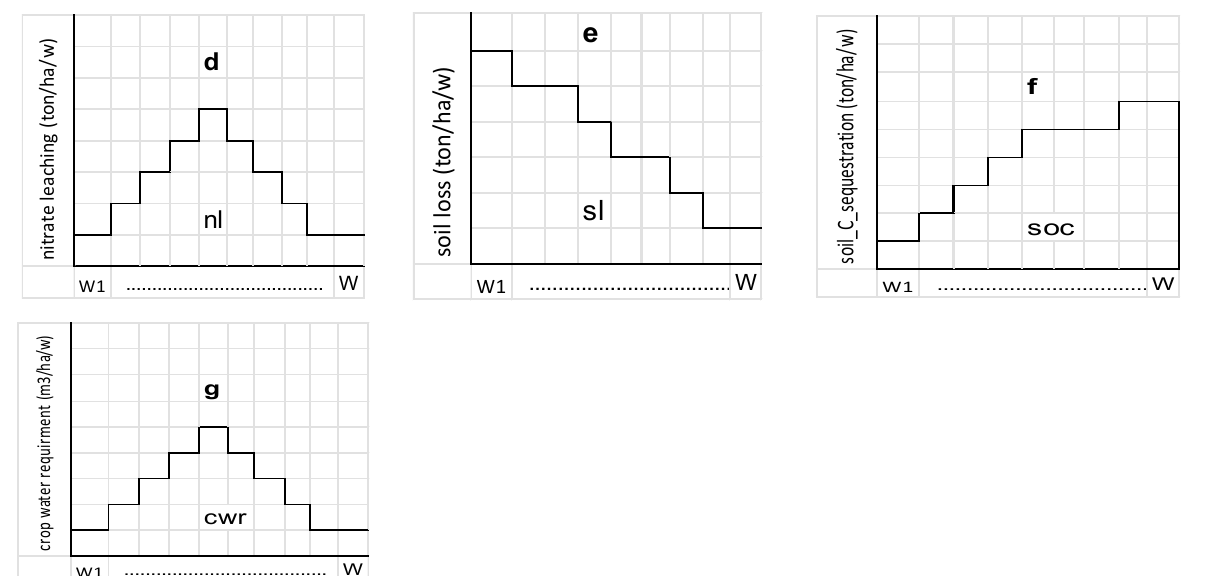
7 of 38 Figure 7. Input data used for the land attribute data sets for alternative crop succession type P1 per unit land per week for one year . (L1P1 land unit 1 for alternative crop succession P1, food calorie(cal in MegKcal/ha/w), crop income (ci in USD/ha/week), crop production cost (cc in USD/ha/week), nitrate leaching (nl in kg /ha/week), soil loss (sl in Kg/ha/week), soil carbon sequestration (soc in Kg/ha/week). For nl, sl, and soc, here expressed in Kg but throughout the model it is used in tons.